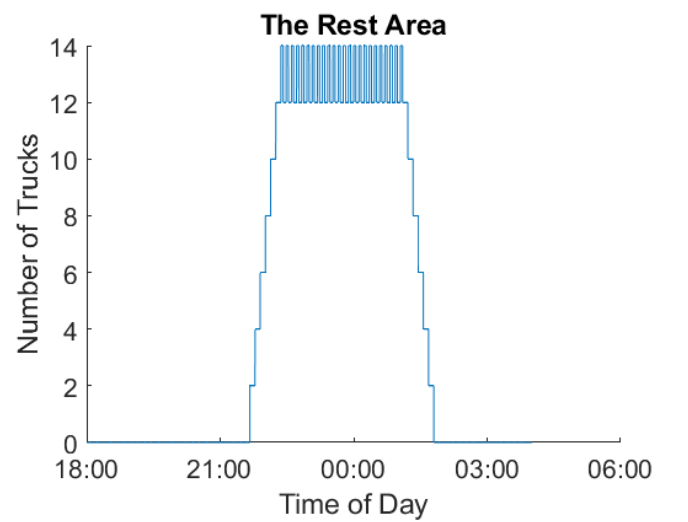
Figure 4. Number of charging trucks at the rest area at different times.